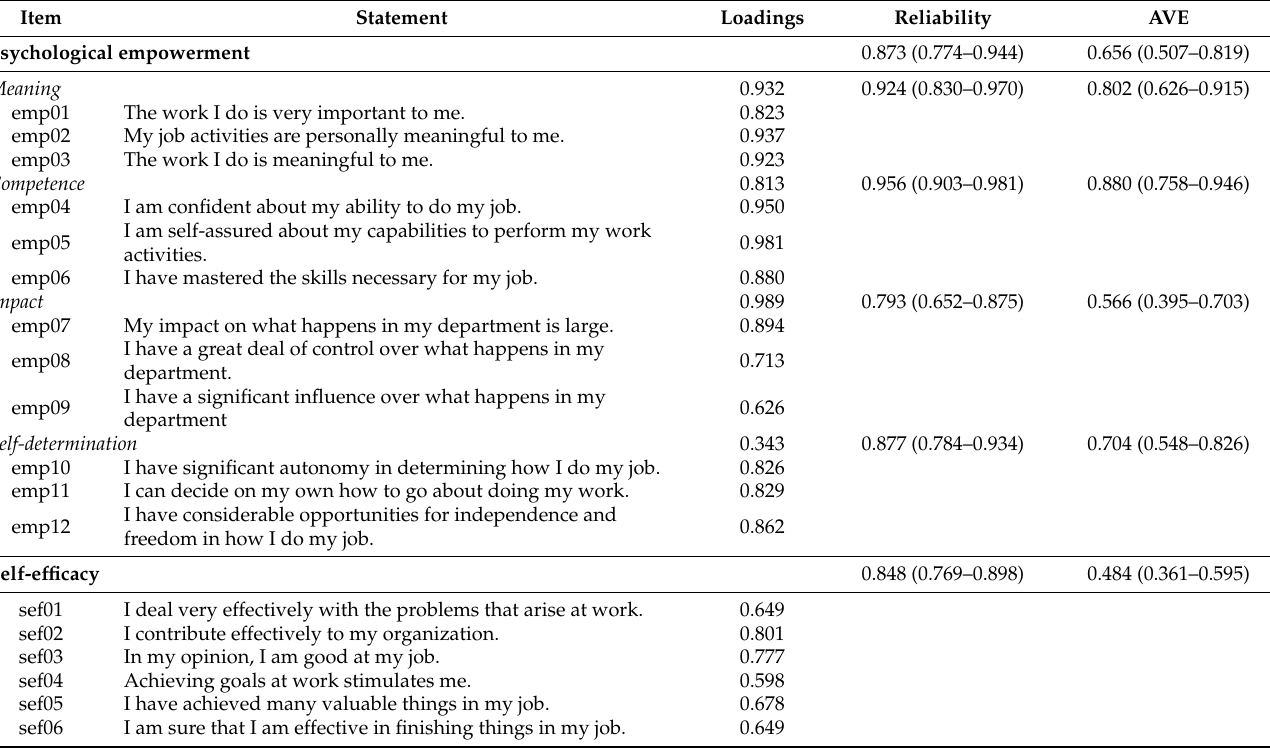
Table 3. Measurement model